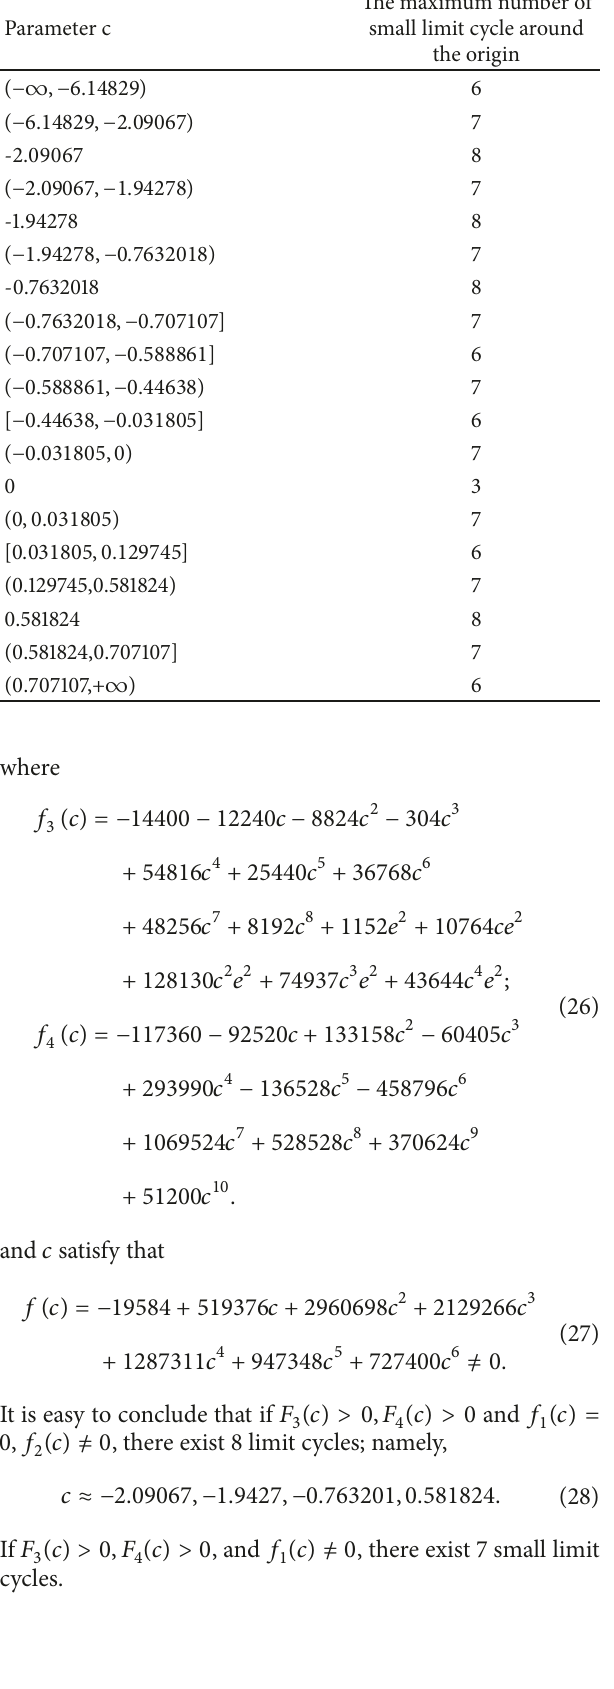
Table 1: The maximum number of small limit cycles around the origin for different parameter c.